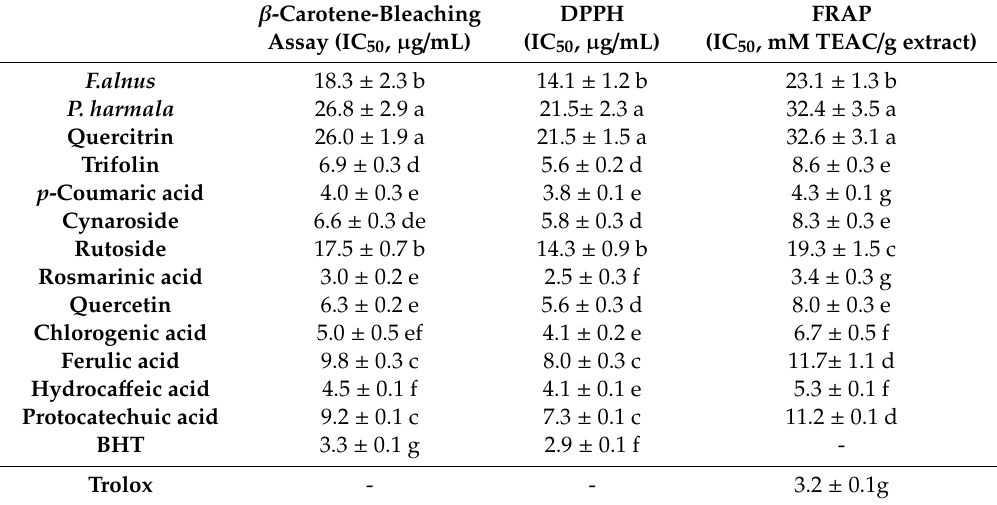
Values are expressed as mean ± standard deviation. TEAC: Trolox equivalent antioxidant capacity. Within column di ff erent letters indicate significant di ff erences ( p ≤ 0.05). FRAP: ferric reducing antioxidant power,